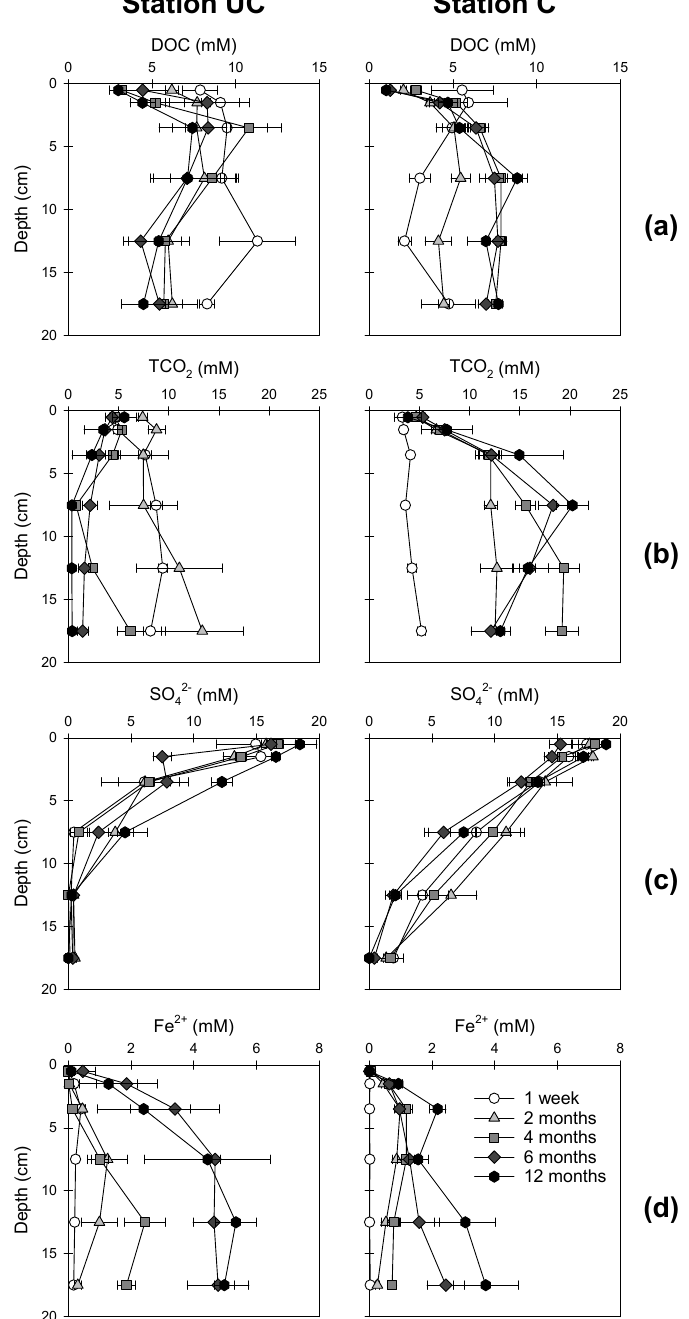
Figure 3. Porewater profiles for dissolved organic carbon (DOC, a ), total carbon dioxide (TCO 2 , b ), sulfate (SO 2 − uncultivated (UC) and cultivated (C) soil flooded with seawater. Error bars indicate SEM ( n =